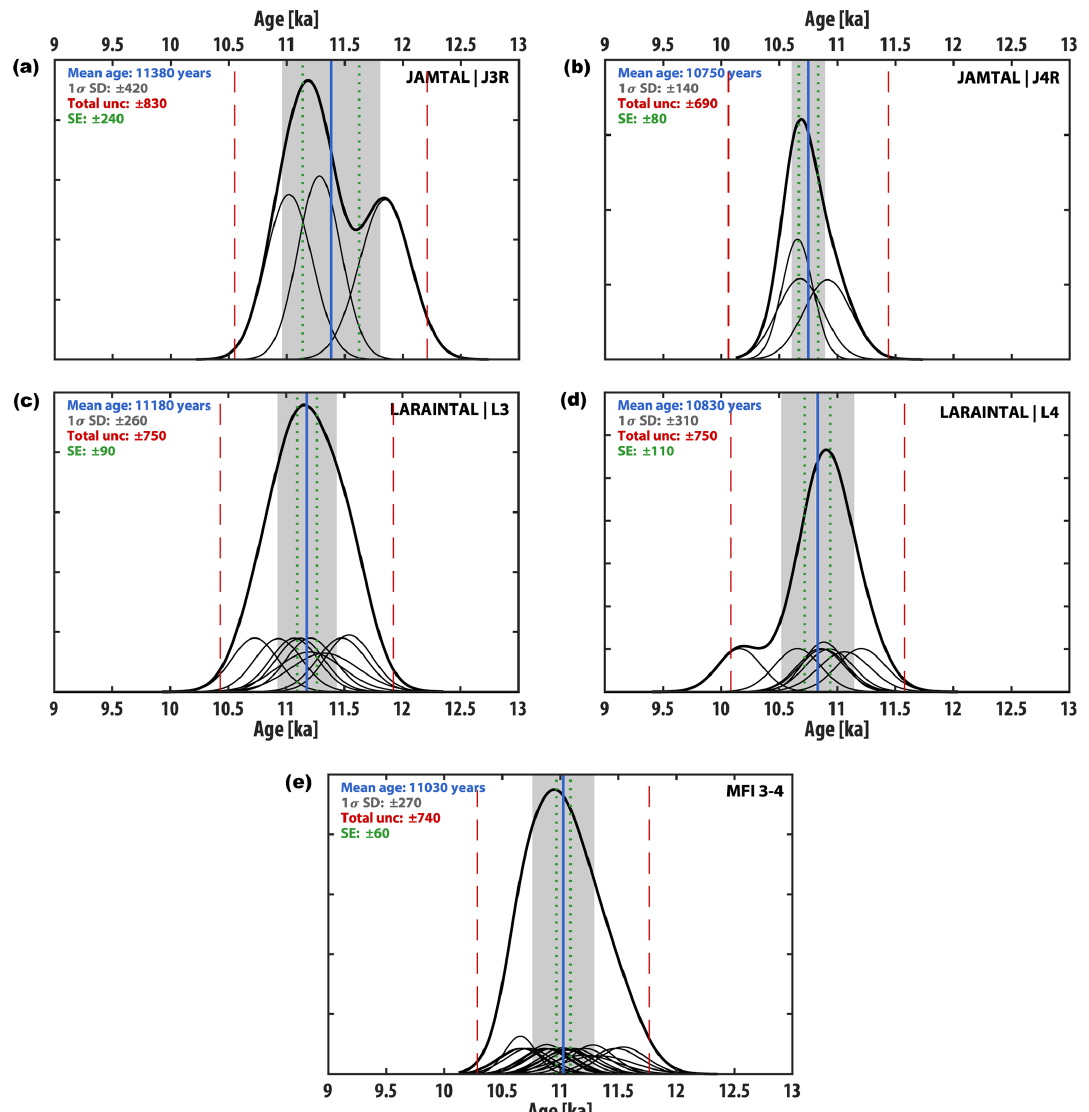
Figure 7. Kernel plots of Holocene moraine ages. (a, c) Inner dated EH moraines at Jamtal and Laraintal. (b, d) Outermost dated EH moraines at Jamtal and Laraintal. (e) Synthesis of moraine ages across both valleys grouped into moraine formation intervals (MFI) MFI 3–4 yielding an age of 11030 ± 740 years rounded to 11.0 ± 0.7ka ( n = 19; outliers: JAM-18-03 and LAR-18-03). Gray-shaded bars illustrate 1 σ standard deviations (SDs) of landform age uncertainties calculated from analytical uncertainties of individual samples. Dashed red lines add the production rate uncertainty (ca. 6.3%) and the uncertainty of the carrier concentration to the 1 σ SD and indicate total uncertainties, which results in conservative uncertainty estimates. Dotted green lines indicate standard errors